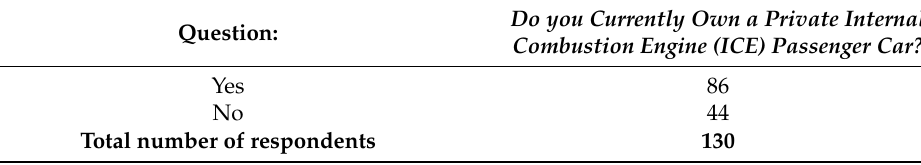
Table A3. Detailed responses to question